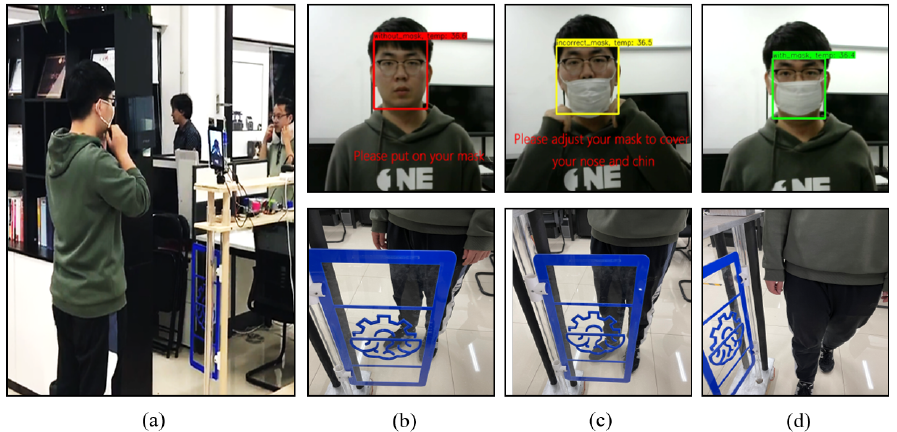
Figure 9. ( a ) An example of user mask detection. Columns ( b – d ) show the different reactions of the application for three kinds of situations. The gate opens only if the detected person wears his/her mask correctly and is in the normal temperature